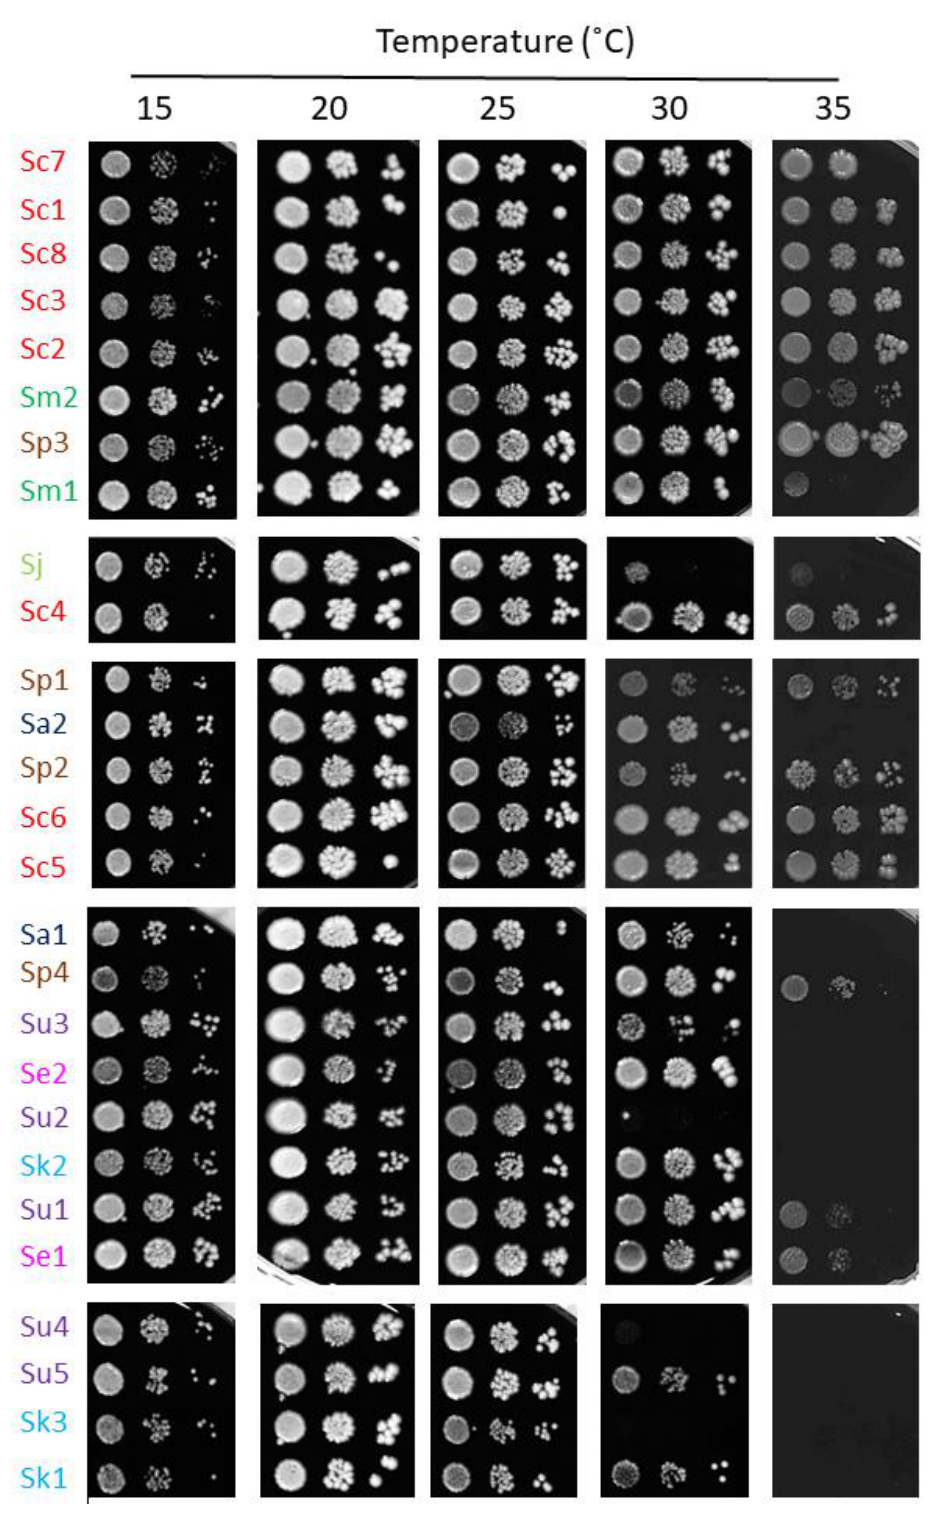
Figure 7. Growth of Saccharomyces strains at different temperatures. Yeasts were cultivated and assayed for growth, as indicated in Figure 5, but plates were incubated at 15, 20, 25, 30 and 35 °C.